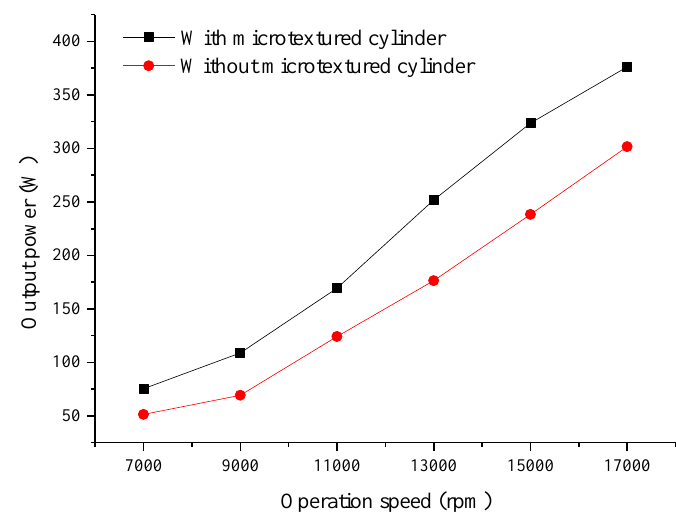
Figure 22. The output power at di ff erent operation speeds of Wankel engine with and without microtextured cylinder.